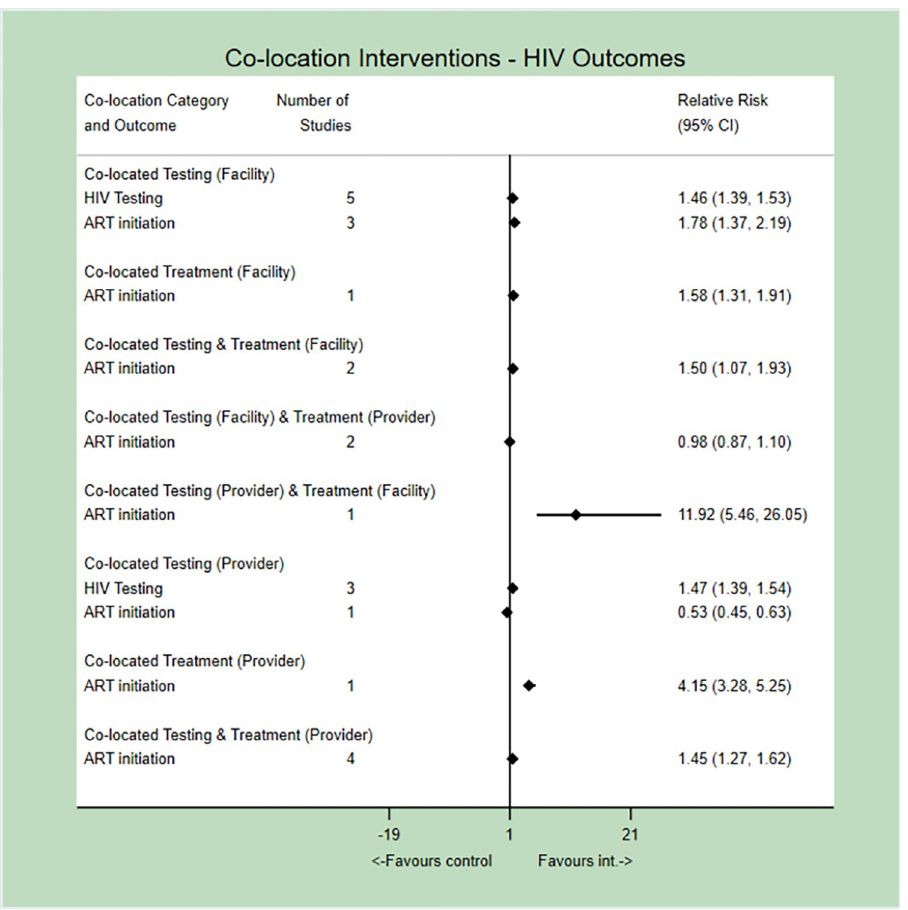
Fig 2. Meta-analysis and forest plot of the effect of co-location interventions (at the facility vs. within the same provider; for just testing, treatment initiation, or both) on outcomes of HIV testing and ART initiation for people with TB (PICO